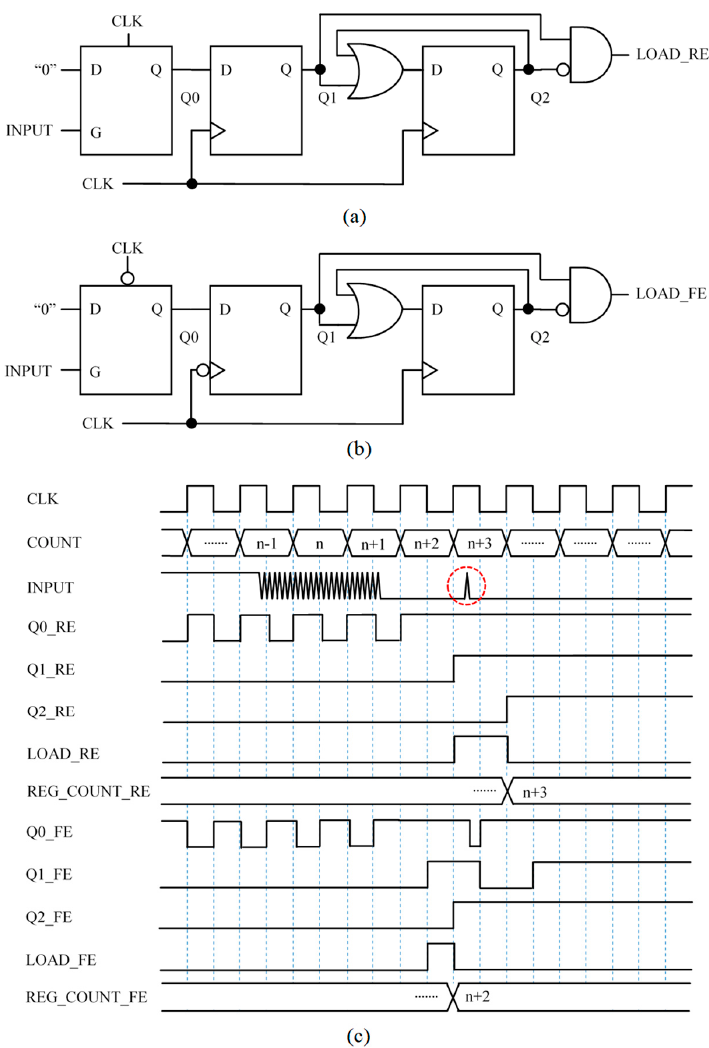
Figure 10. Capture Module 6—circuit triggered with the rising and falling edge of the clock signal to average four counts: ( a ) circuit triggered with the rising edge; ( b ) circuit triggered with the falling edge; and ( c ) chronogram.